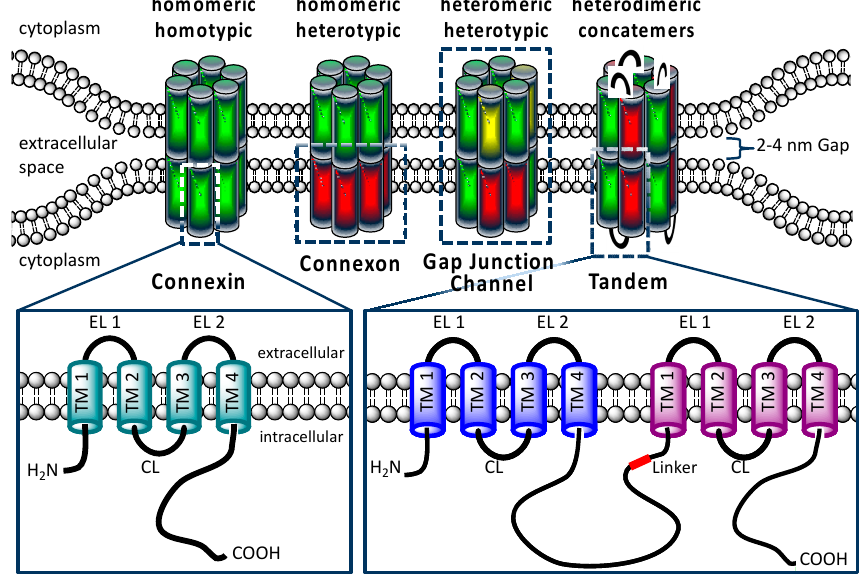
Figure 1. Structural organization of connexins and gap junctions. A gap junction channel is composed of two hemichannels or connexons, which consist of six connexins. Connexins have four transmembrane domains (TM), two extracellular loops (EL), one cytoplasmatic loop (CL), as well an intracellularly localized N- and C-terminus. Homomeric connexons and homotypic gap junction channels are formed by a single connexin isoform. In the postulated heteromeric connexons and heterotypic gap junction channels, different connexin isoforms are expected. The lower right pictogram shows the constructed concatemeric connexins as heterodimeric tandem.